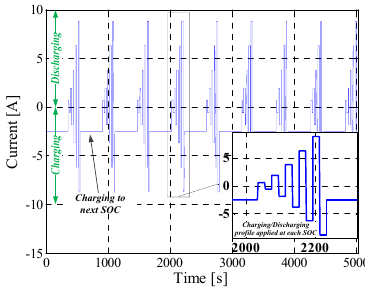
Figure 22. Dynamic current profile used for verification of the LFP/C battery performance model.